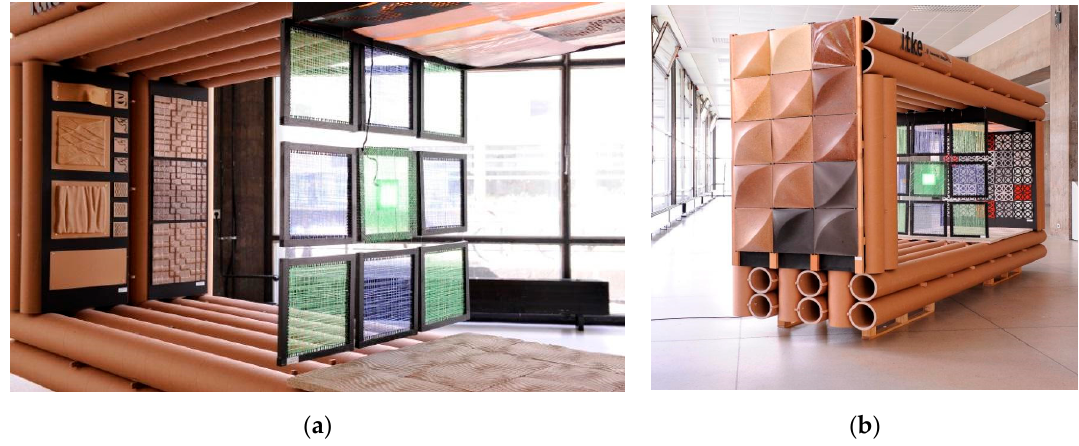
Figure 7. ( a ) Interior cladding applications and hanging partitions of the Eco-Pavilion (left to right): Vacuum thermoformed biocomposite prototypes, hanging partition wall from recycled plastic bottles; ( b ) Exterior cladding application with free-form facade panels. © BioMat/ITKE—University of Stuttgart. Photos: Miklautsch.